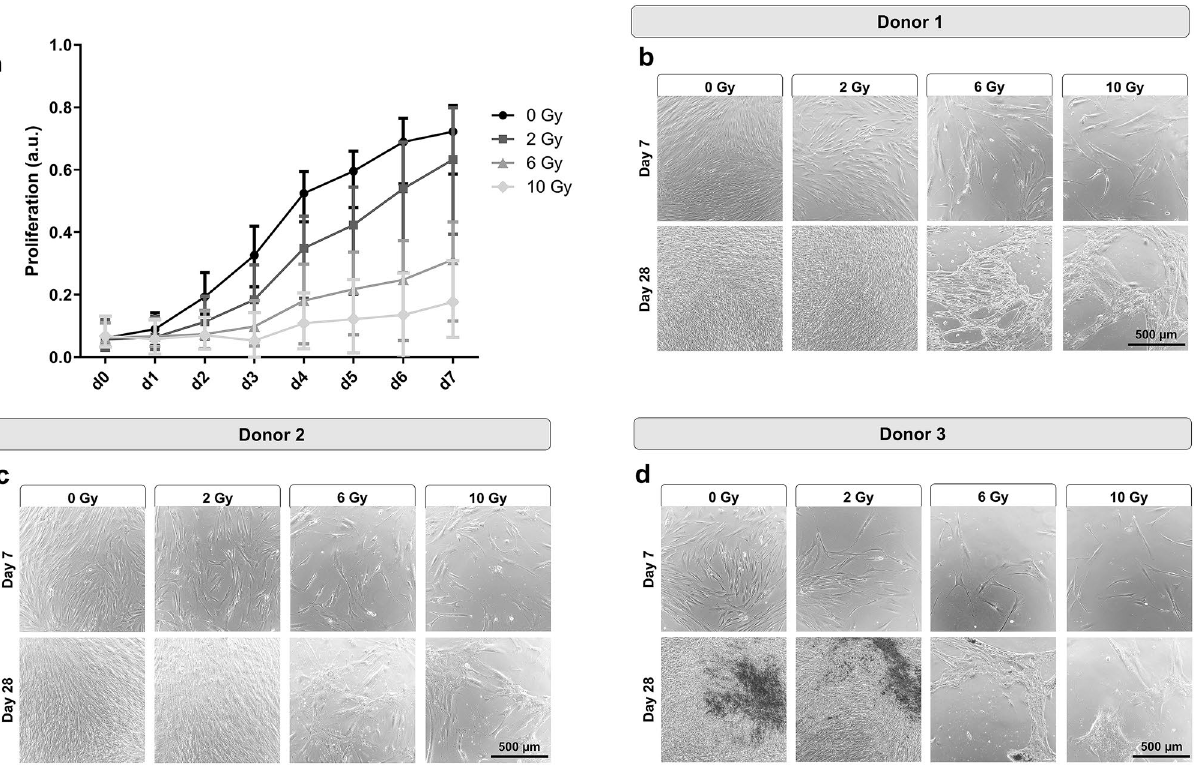
Figure 1. Impact of irradiation on the proliferation of JHOBs. ( a ) Proliferation is inversely proportional to the MFI of the CellTrace Violet dye. JHOBs were stained with CellTrace Violet, seeded, and irradiated the next day. Sampling was performed every day and cells were analyzed using flow cytometry. Proliferation index is calculated as the inverse normalized MFI of CellTrace. Data are presented as mean ± s.d. n = 3 donors, where three biological replicates were analyzed for each donor. ( b – d ) Microscopic images of JHOBs on day 7 and 28 after